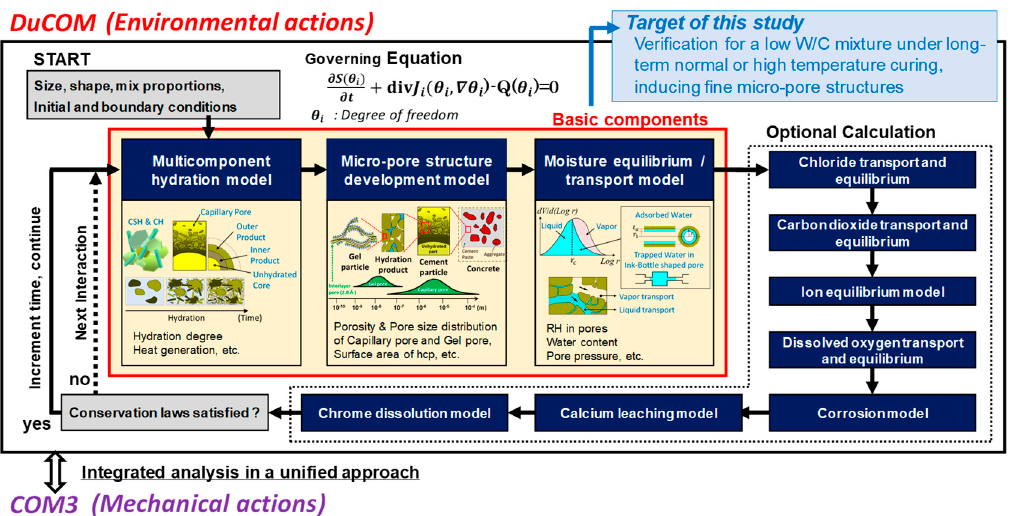
Figure 2. Target of this study in DuCOM-COM3.